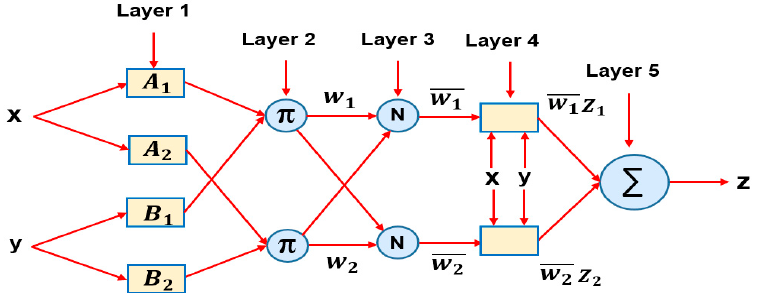
Figure 1. ANFIS model architecture.